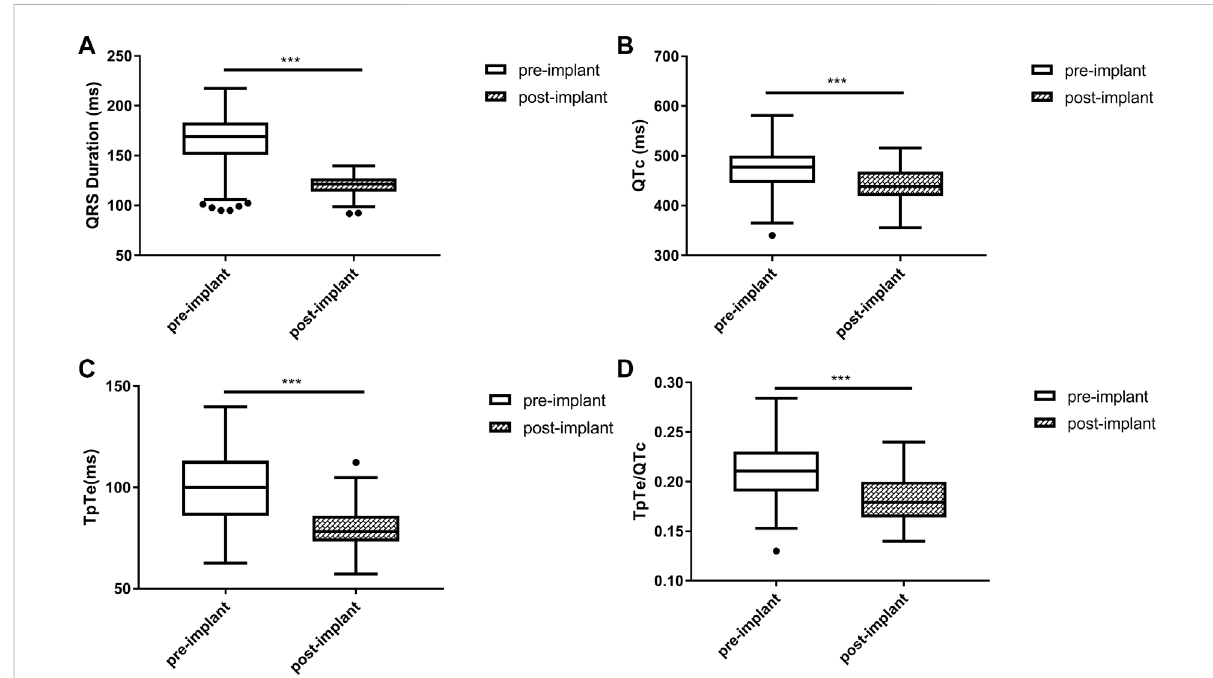
FIGURE 1 Changes in QRS duration (A) , QTc (B) , TpTe (C) , TpTe/QTc (D) before and after LBBAP in HF patients ( n = 59). (Box plots exhibited the smallest nonoutlier, fi rst quartile, median, third quartile, and largest non-outlier of each variable from bottom to top. HF, heart failure; LBBAP, left